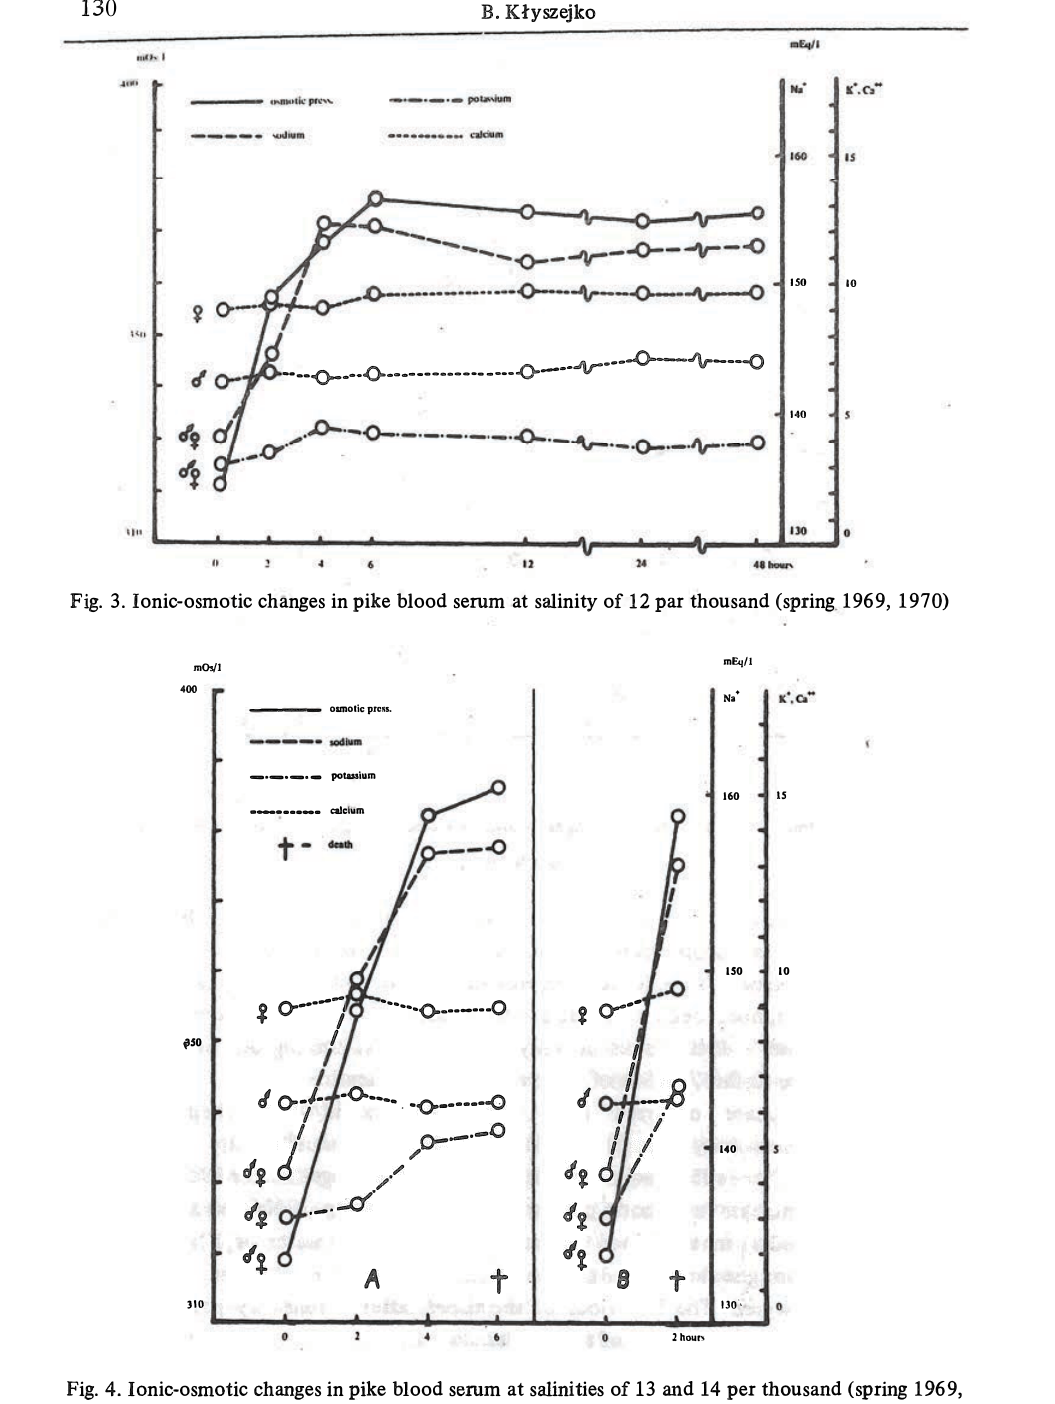
Fig. 4. Ionic-osmotic changes in pike blood serum at salinities of 13 and 14 per thousand (spring 1969, 1970). A -salinity of 13 per thousand; B -salinity 14 per